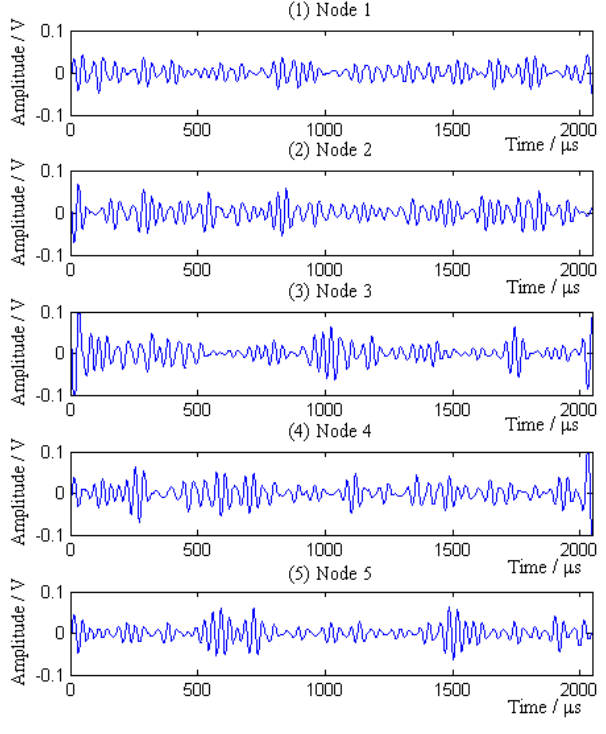
Figure 12. Single mode signals extracted from five original